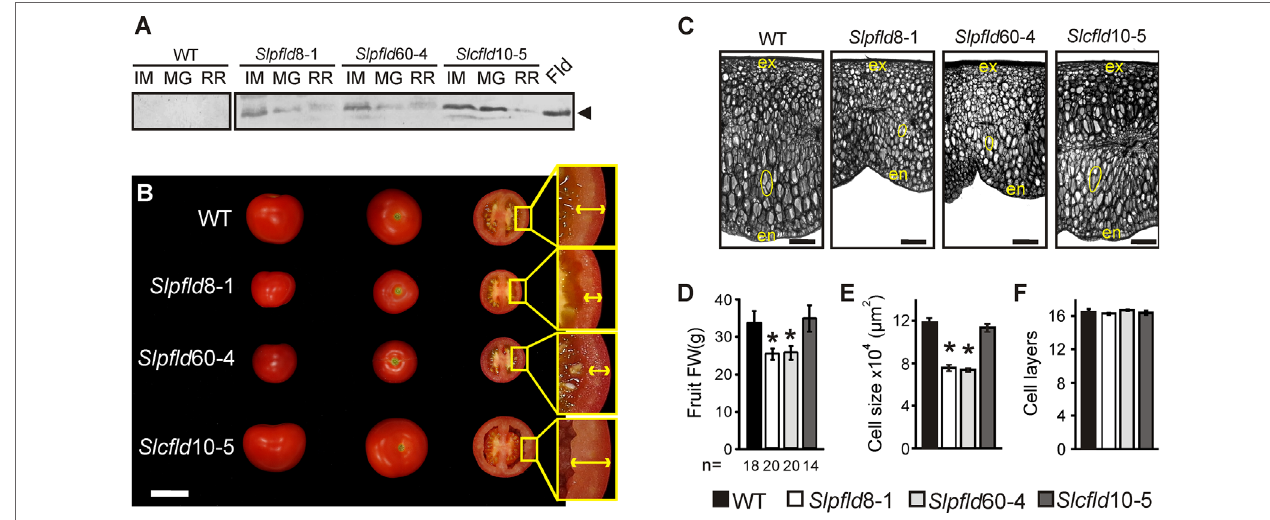
FIgURE 5 | Plastid-located flavodoxin (Fld) affected tomato fruit development. (A) Fld expression at different fruit stages: immature green (IM), mature green (MG), and ripe red (RR). Cleared extracts corresponding to 5 mg FW were loaded in each lane, resolved by 15% sodium dodecyl sulfate–polyacrylamide gel electrophoresis and analyzed by immunoblot using Fld antisera, as described in Materials and Methods . The two membranes were assayed together and over- reacted to reveal unspecific staining. Purified Fld (0.8 pmol) is shown in the extreme right. MW: molecular weight marker. (B) Phenotypes of representative fruits from each line. Bar = 5 cm. Insets show pericarps delineated by arrows. (C) Pericarp sections from representative breaker fruits stained with toluidine blue. The inner epidermis is denoted as "en" and the outer epidermis as "ex." Typical cells are contoured in yellow to illustrate size differences. Bar = 1 mm. (D) Average fruit weight, n indicates the number of fruit assayed. Cell size (E) and the number of cell layers of the pericarp (F) were calculated from six biological replicates using sections as those depicted in panel (C). Data presented correspond to means ± SEM. Statistically significant differences are indicated by asterisks and were determined using one-way ANOVA and Tukey's multiple comparison test ( P < 0.05).